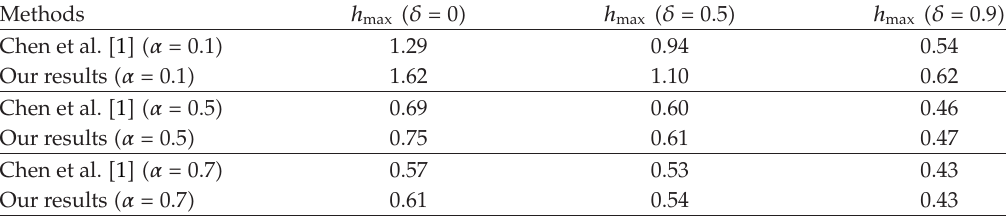
Table 2: Comparison of the maximum allowed time delay h